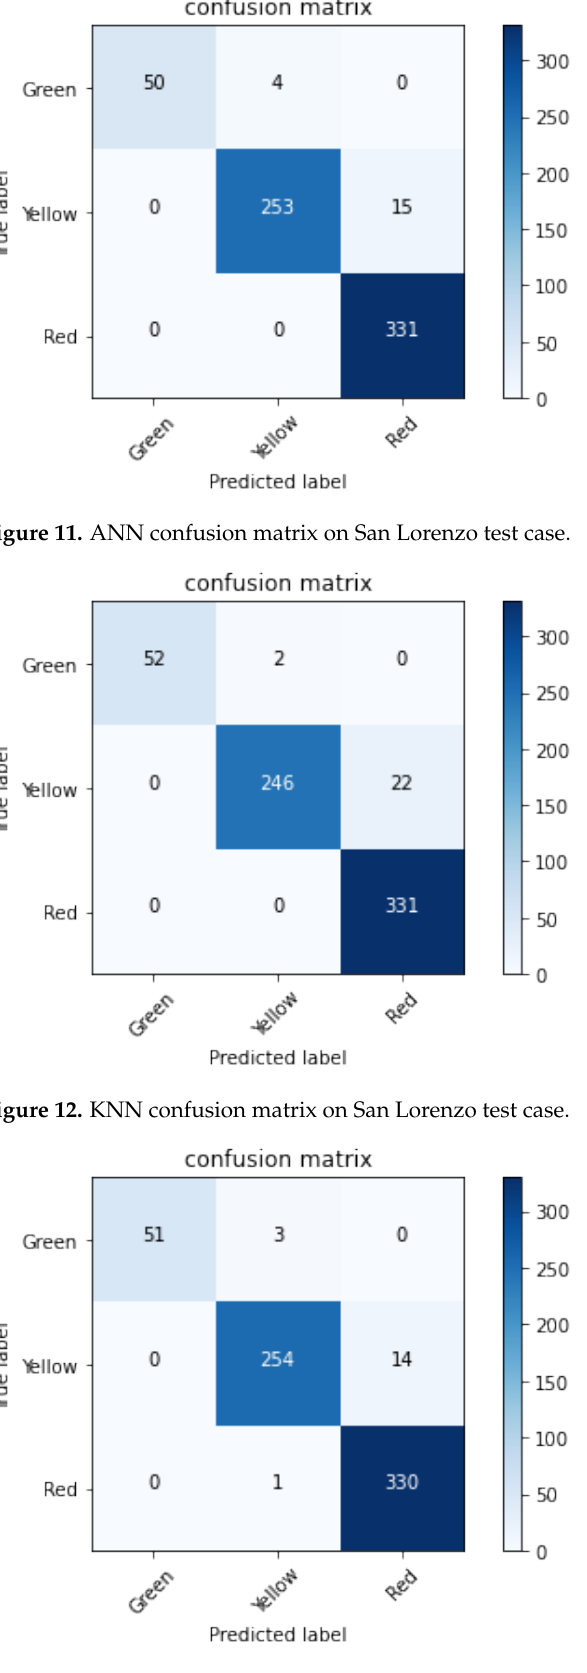
Figure 13. Random Forest confusion matrix on San Lorenzo test